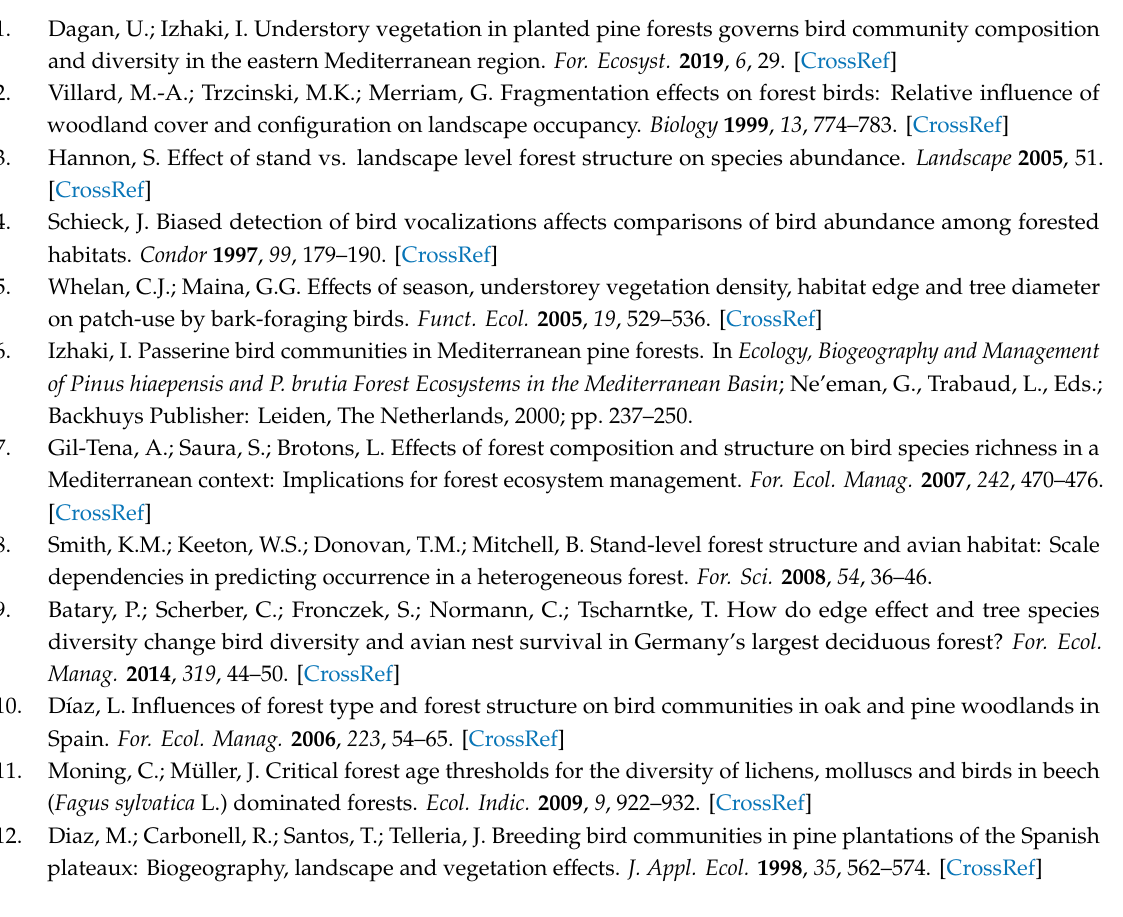
Table S1. Mixed-model table of abundance during mobbing trials and the influence of habitat, season, and caller species. Table S2. Mixed-model table of species richness during mobbing trials and the influence of habitat, season, and caller species. Table S3. Mixed model of distance of the responding birds from the speaker during mobbing trials and the influence of caller species and habitat in the dense forest (DF) and in the open forest (OF). Table S4. Di ff erences between observed and expected numbers of responding birds to mobbing calls in the winter in the dense forest (DF) and in the open forest